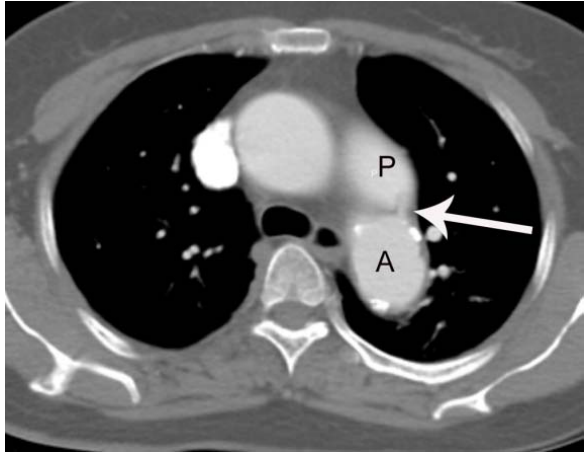
Figure 2. A case of PDA in a 56 -year-old female patient (group 2) missed on both the initial CT report and by the two blind readers. On axial post-contrast images with 3 mm slice-thickness at the level of tracheal carina, a small linear enhancing structure (arrow) connecting the left main pulmonary artery (P) and aortic isthmus (A) is subtly noted, but was missed on the initial CT reading.